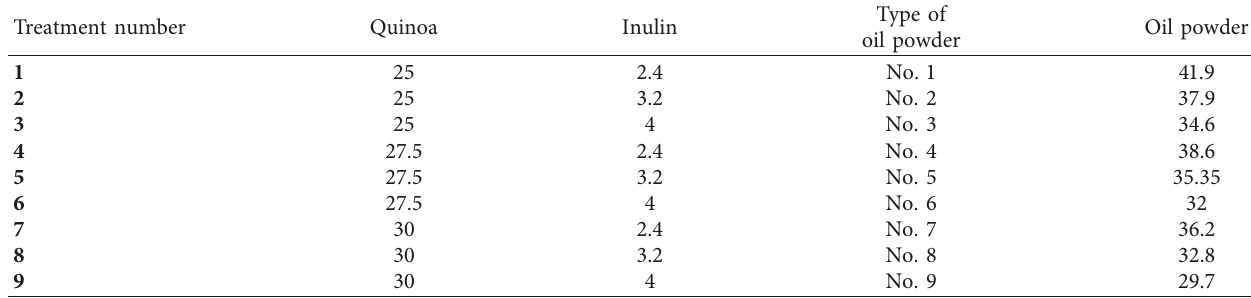
Table 2: Variable ingredients of the cake powders